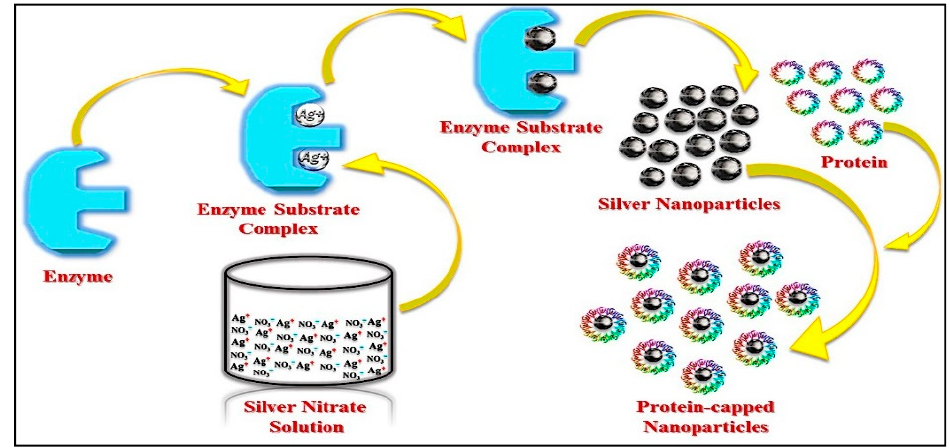
Figure 6. Fungal synthesis of Ag-NPs [47].